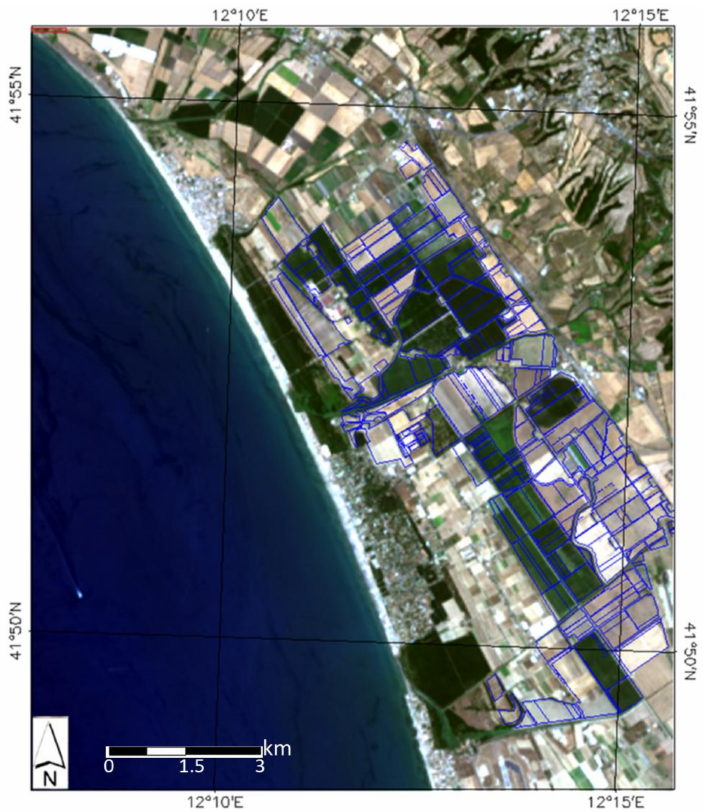
Figure 1. Overview of the 94 FOI (depicted in blue color) in the imagery acquired by Landsat 8 on 17th July 2015. Eastings and northings are in geographic coordinates